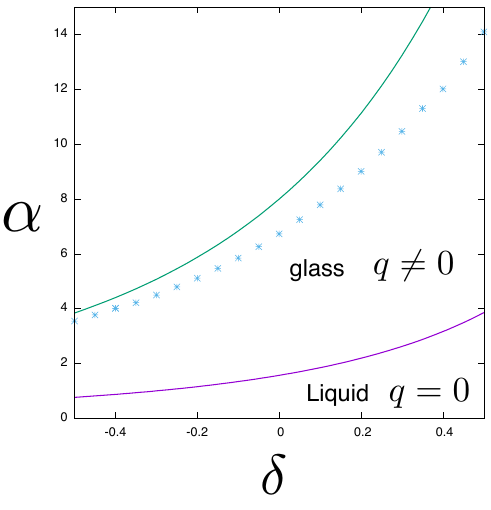
Figure 6: The phase diagram of the p = 2 body hardcore model within the replica symmetric (RS) ansatz: q > 0 RS solution emerges continuously at the lower curve ( δ ) given by Eq. (235). The value of the order parameter which represents α = α c ( δ ) given by Eq. (237), which saturates q → 1 approaching the upper solid line α = α j is the jamming line within the RS ansatz. The lower curve coincides with the AT line above which the RS solution becomes unstable. The dotted line is the jamming line obtained by the continuous RSB solution which is discussed